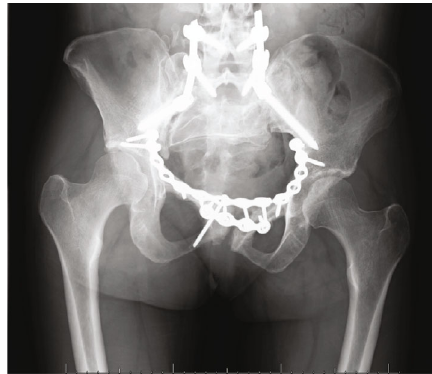
Figure 5: Failure of metalwork in one of the pelvic suprasymphyseal plates was identi fi ed on the left side and was managed